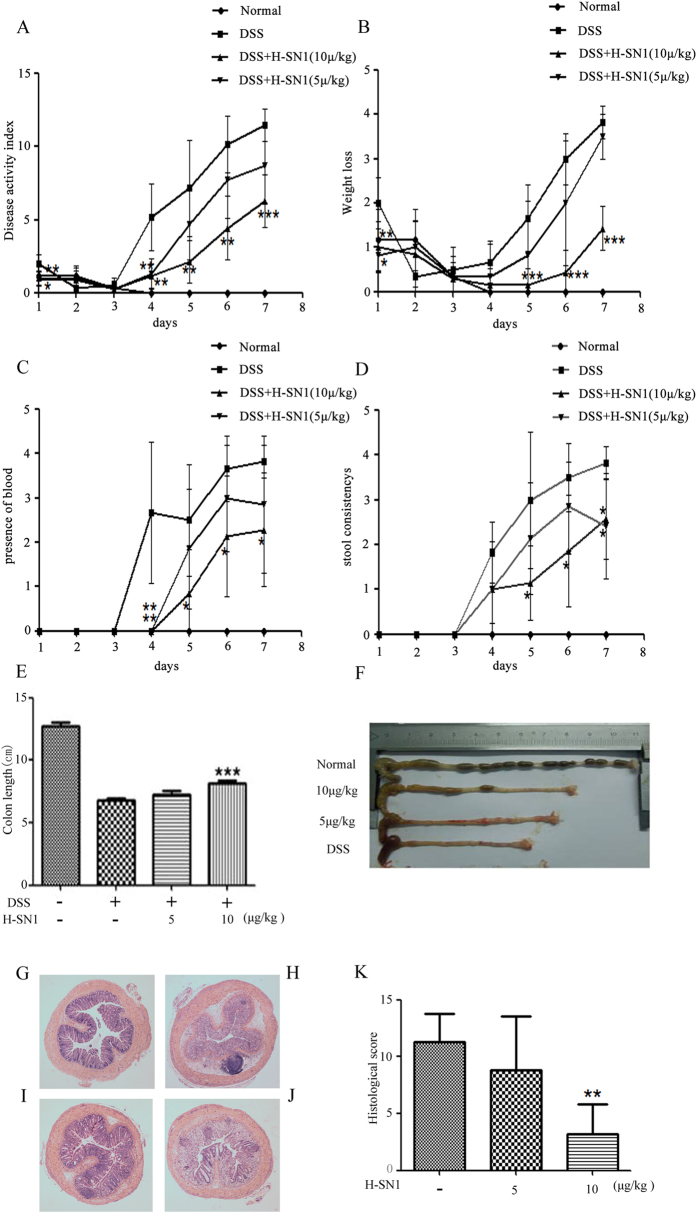
H-SN1 improves clinical parameters and reduces histologic injury in DSS-induced acute colitis.(A) BALB/c mice received DSS for 7 days, and DAI (as shown in Table 1) was monitored. Effects of daily intraperitoneal injections of H-SN1 on weight loss (B), fecal bleeding (C) and recovery from diarrhea (D). (E,F) Effect of H-SN1 on colon length in mice with DSS-induced acute colitis as assessed by histopathological changes: (G) Normal control mice; (H) DSS treated mice; (I) DSS + 10 μg/kg H-SN1 treated mice; and (J) DSS + 5 μg/kg H-SN1 treated mice. (K) Total histologic score. Values represent the means ± SEM, *p < 0.05, **p < 0.01, ***p < 0.001 for DSS + H-SN1 compared with DSS + vehicle. Hematoxylin & eosin staining magnification 40×.